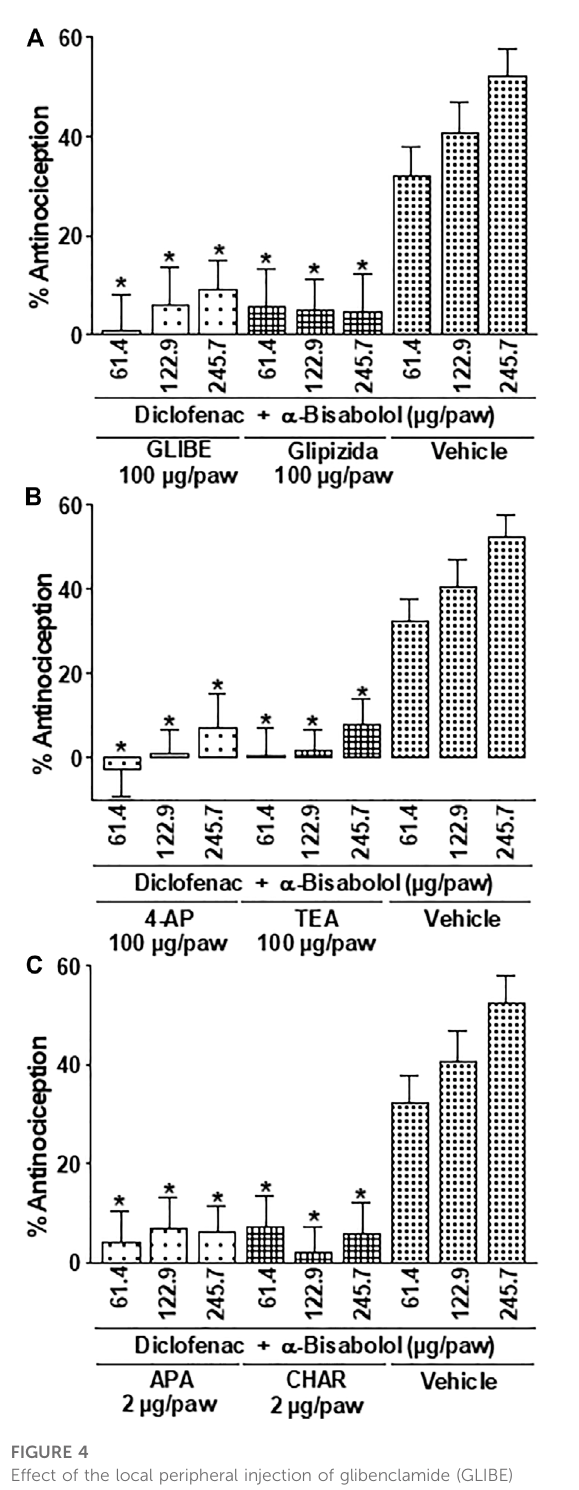
FIGURE 4 Effect of the local peripheral injection of glibenclamide (GLIBE) (A),glipizide (A) ,4-AP (B) ,TEA (B) ,apamin (C) orcharybdotoxin(CHAR) (C) on the antinociceptive activity of the α -Bisabolol-diclofenac combinations during the formalin test. Rats received a local injection of α -Bisabolol ( − 20 min), diclofenac ( − 13 min) and then the inhibitors ( − 7 min) into the right paw. Results are expressed as the antinociception percent on phase two. Each point corresponds to the mean±SEMof5-6animals.*Signi fi cantdifferencefromvehiclegroup ( p < 0.05) as determined by the analysis of variance followed by Dunnett ’ s